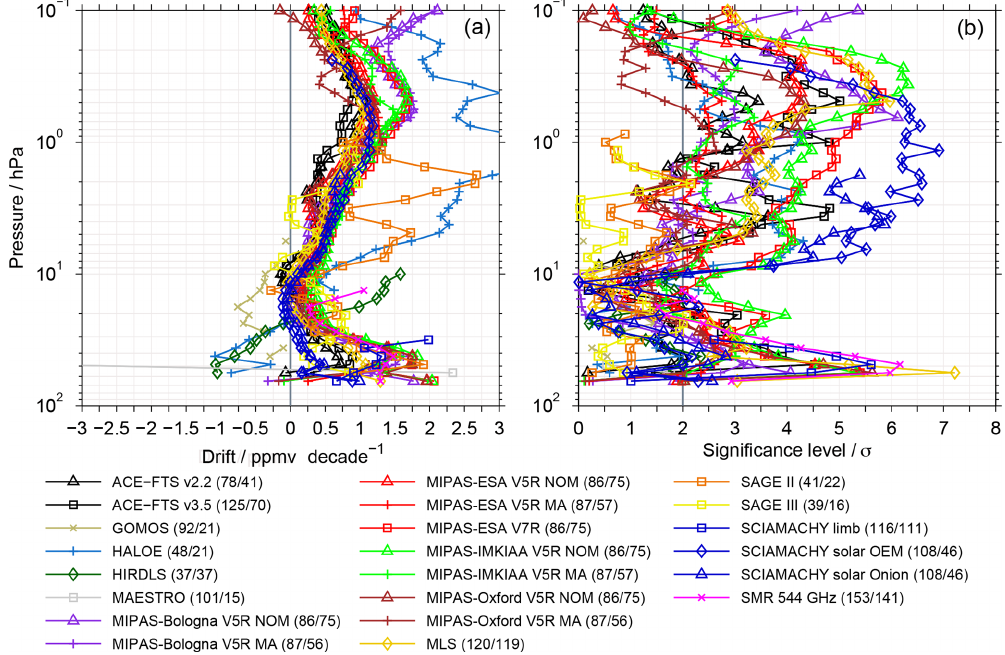
Figure 10. Panel (a) shows the drift of the SMR 489GHz data set relative to other data sets. In (b) the corresponding significance level of the drift estimates are shown. This example considers the latitude band between 30 and 60 ◦ N. In the legend the first number indicates the maximum overlap period in terms of months (over all altitudes) of the two data sets compared, i.e. the time between the first and the last month sufficient coincidences were found between the two data sets. The second number indicates during how many months both data sets actually yield sufficient coincidences, again represented by the maximum over all altitudes. As in Fig. 4 only results at every second altitude are plotted for better